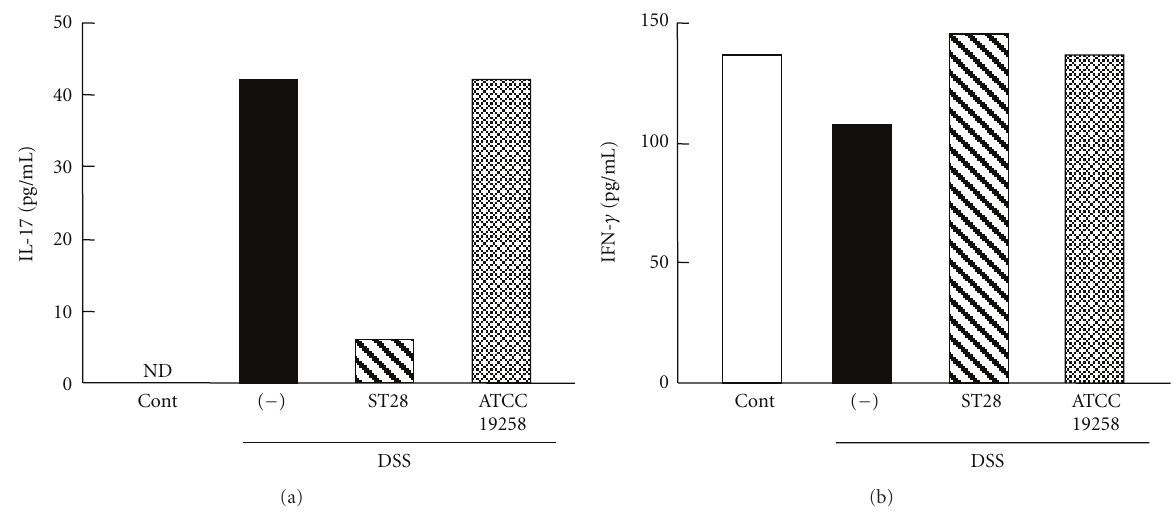
Figure 3: E ff ects of S. thermophilus ST28 administration on cytokine production in the lamina propria lymphocytes (LPLs) from DSS- induced colitis mice. LPLs from DSS-induced mice orally administered ST28 or ATCC 19258 were incubated with anti-CD3 and anti-CD28. Culture supernatants were harvested and assayed for concentrations of IL-17 (a) and IFN- γ (b). LPLs from untreated DSS-induced colitis mice ( − ) and healthy control mice (Cont) were also assayed. ND, not detected.